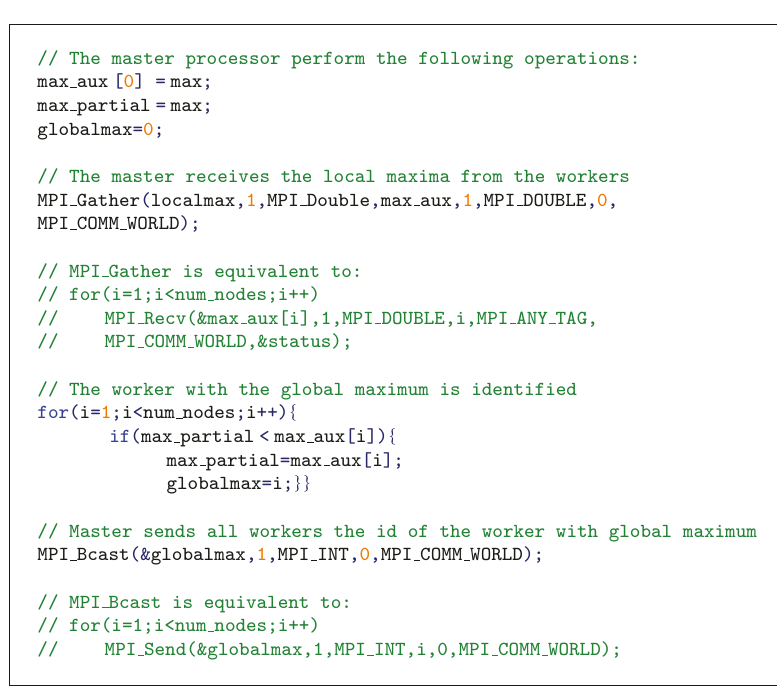
Figure 6: Portion of the code of the master in our P-ATDCA implementation, in which the master receives the local maxima from the workers, computes a global maximum, and sends all workers the id of the worker which contains the global